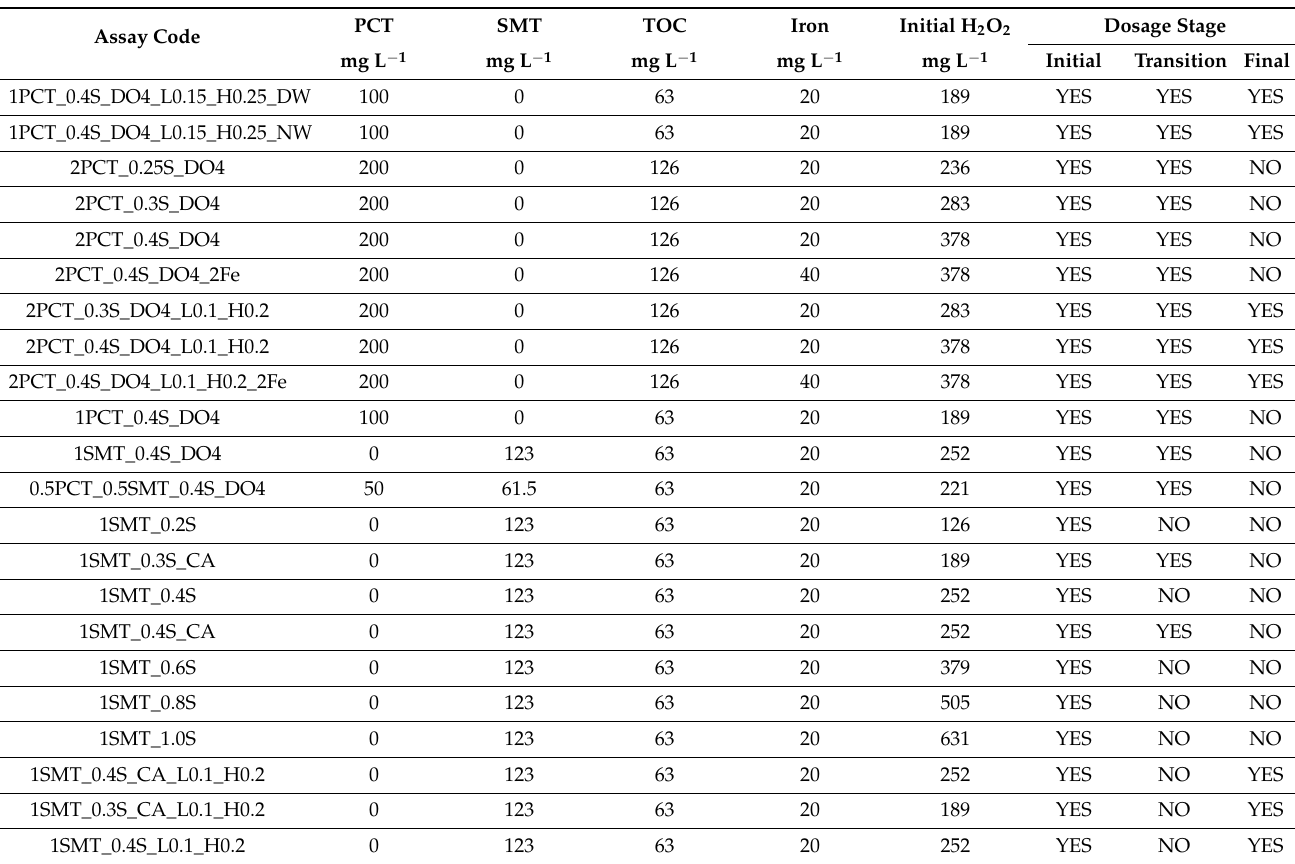
Table 2. Experimental